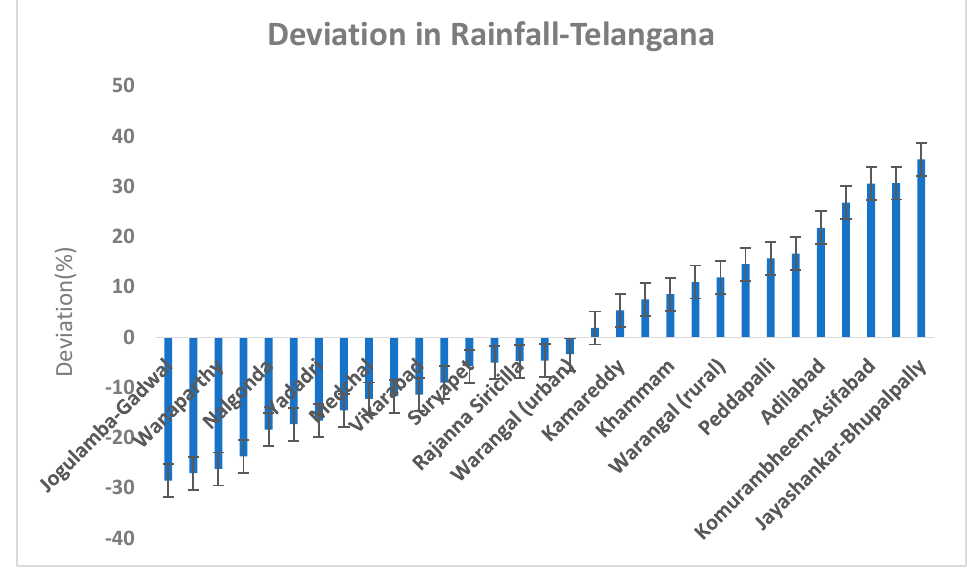
Figure 4. Mandal-wise difference in rainfall distribution from the state’s mean from 1970 to 2014.